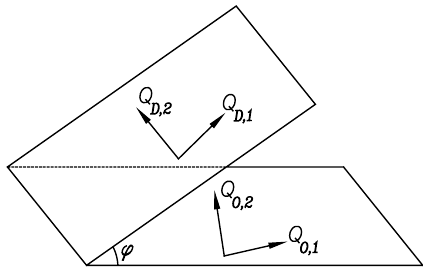
Figure 1. Angle formed by active subspaces representing the reference and current